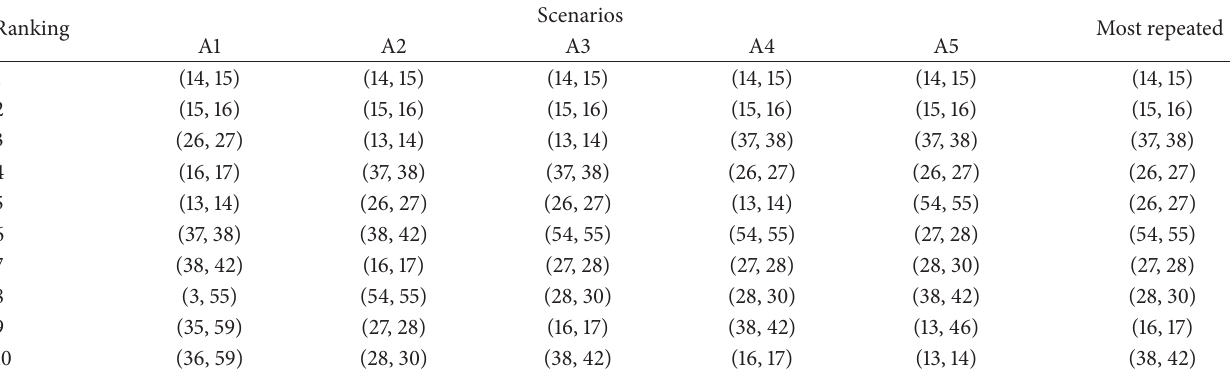
Table 3: List of ten top ranked edges for different scenarios.